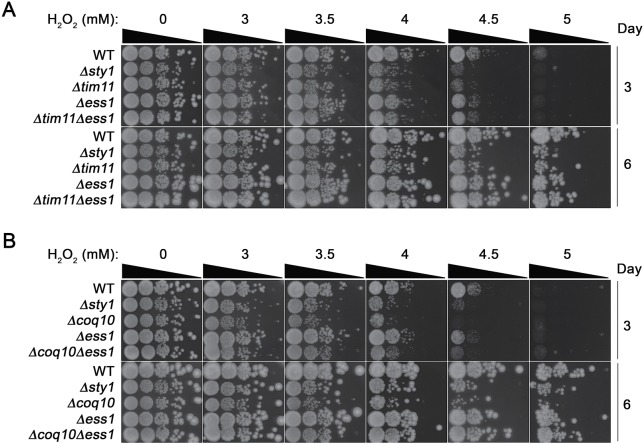
Positive genetic interaction between Ess1 and mitochondrial oxidative phosphorylation regulators in fission yeast.Hypersensitivity to hydrogen peroxide (H2O2) of null mutations of ess1 and (A) tim11 and (B) coq10 were tested by exposing to the oxidizing agent. Cells were serially diluted and spotted onto YEA media containing 0, 3, 3.5, 4. 4.5 and 5 mM of H2O2. Cell growth was documented for 3 and 6 days after spotting. Δsty1 strain was employed as a positive control. The result is a representative of three independent spotting experiments.